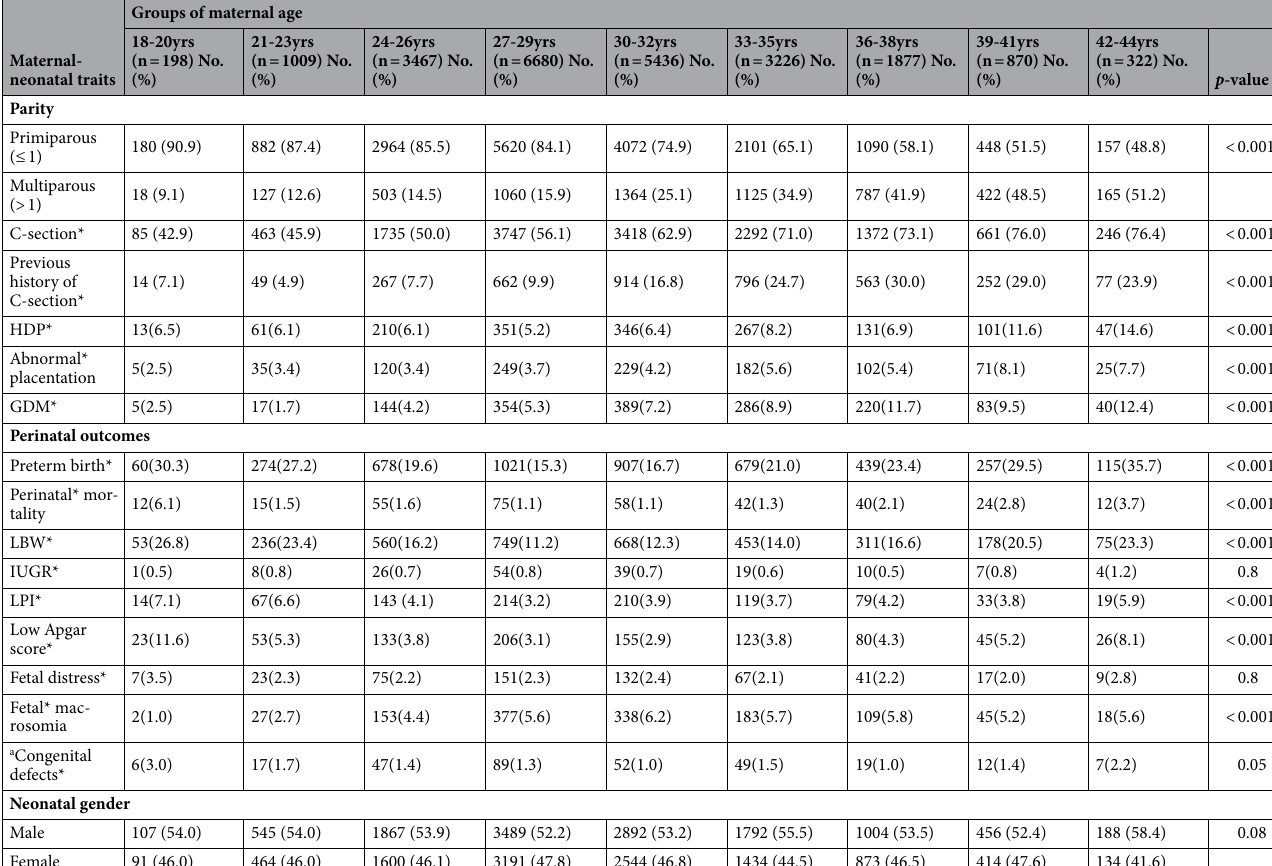
Table 1. Distribution of maternal-neonatal traits across different maternal age groups (N = 23,085). HDP Hypertensive disorders of pregnancy, GDM Gestational diabetes mellitus, LBW Low birth weight,